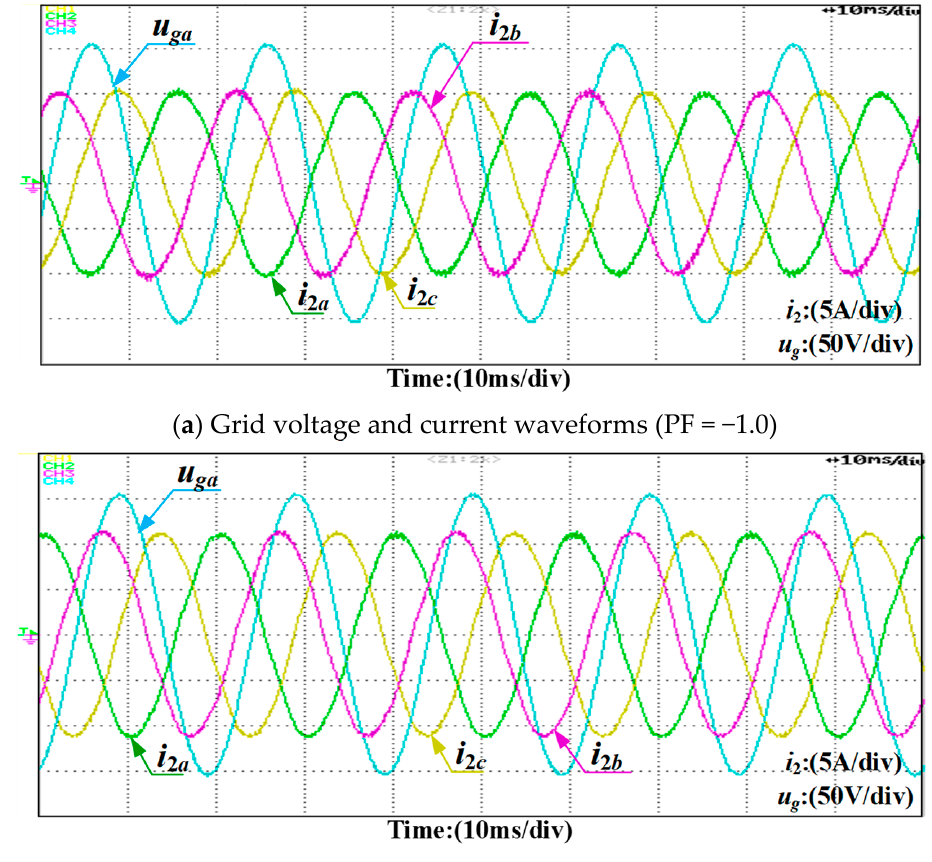
Figure 16. Steady state waveforms of the PCS for charging operation.